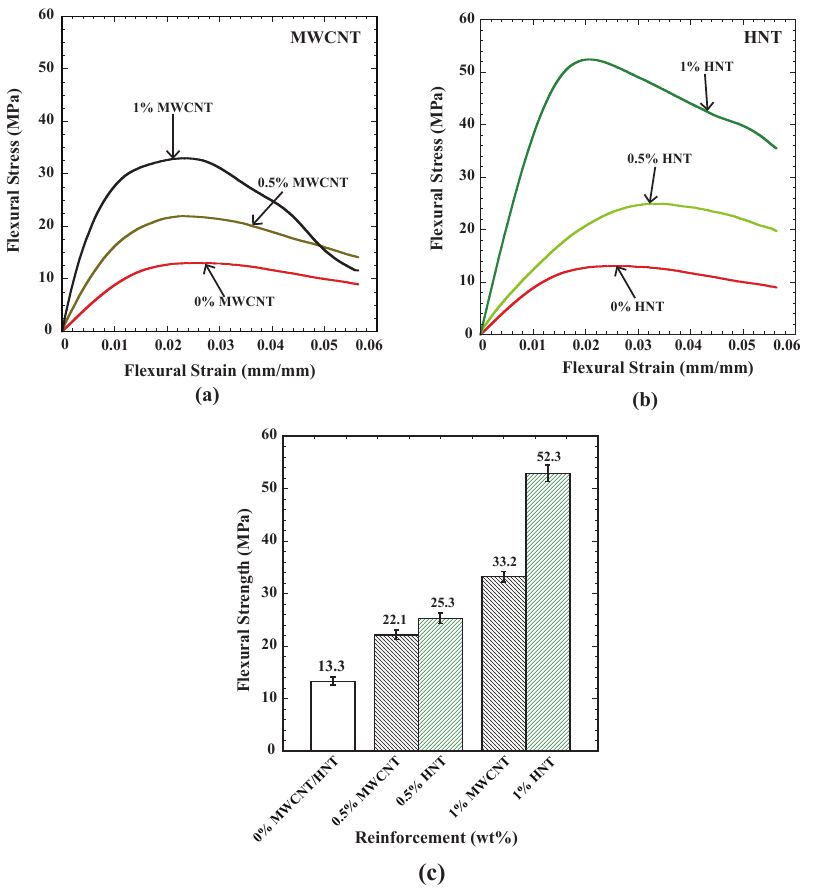
Figure 6. ( a ) Flexural stress vs. flexural strain for SMPU and MWCNT composite 4D-printed specimens; ( b ) flexural stress vs. flexural strain for SMPU and HNT composite 4D-printed specimens; ( c ) flexural strength for all the considered cases of 4D-printed